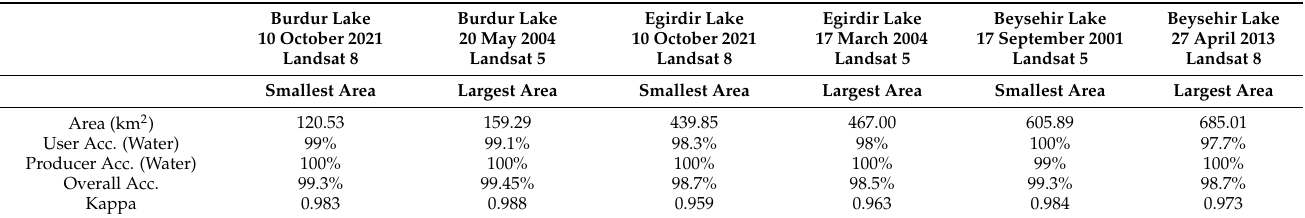
Table 5. The accuracy assessment results of extracted water pixels with